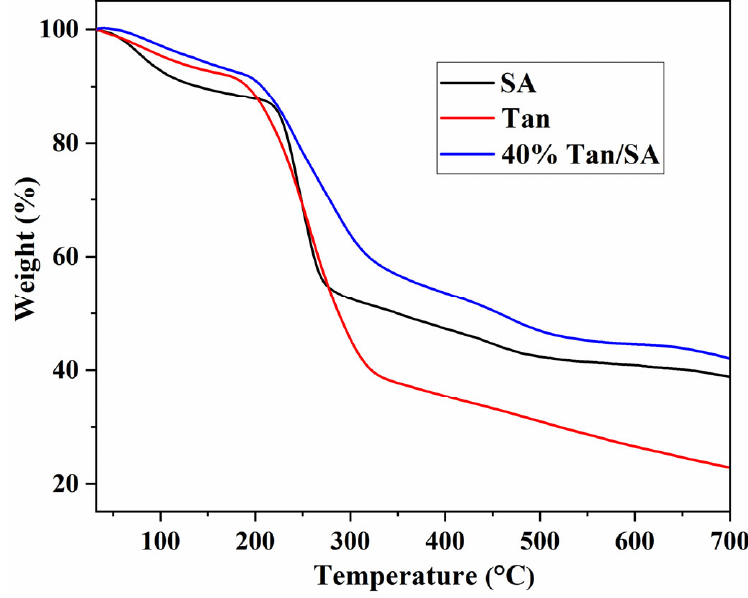
Figure 5. TG spectra of SA, Tan and 40% Tan/SA beads.